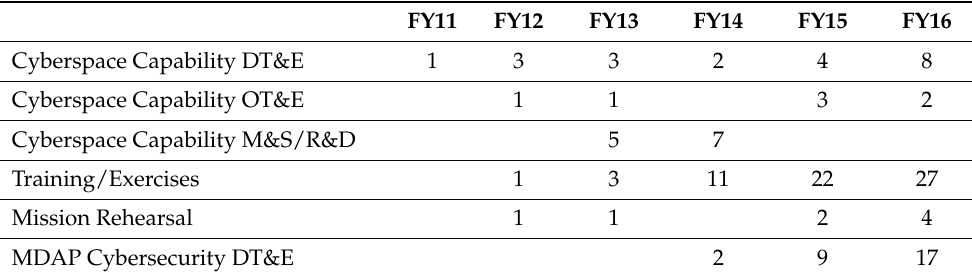
Table 1. Number of NCR Uses by